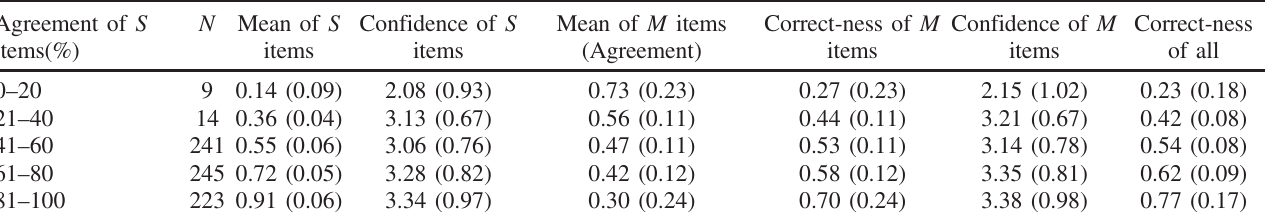
TABLE IV. Distribution of the participant with varied scores in items about scientific properties. Note that M items represent items regarding the materialistic property of sound; S items represent items regarding the process property of sound. Agreement of S